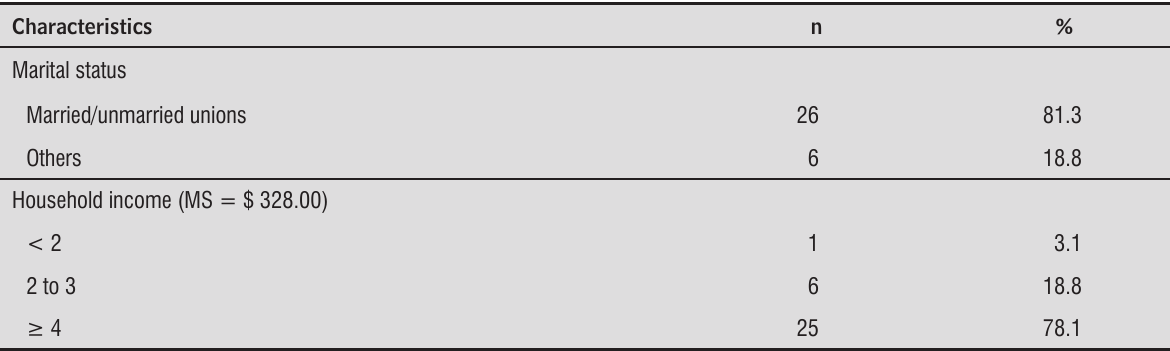
Table 1 - Socio-demographic characteristics of the obese adults, according to absolute (n) and relative ( % ) frequencies. Joinville, SC, Brazil, 2010